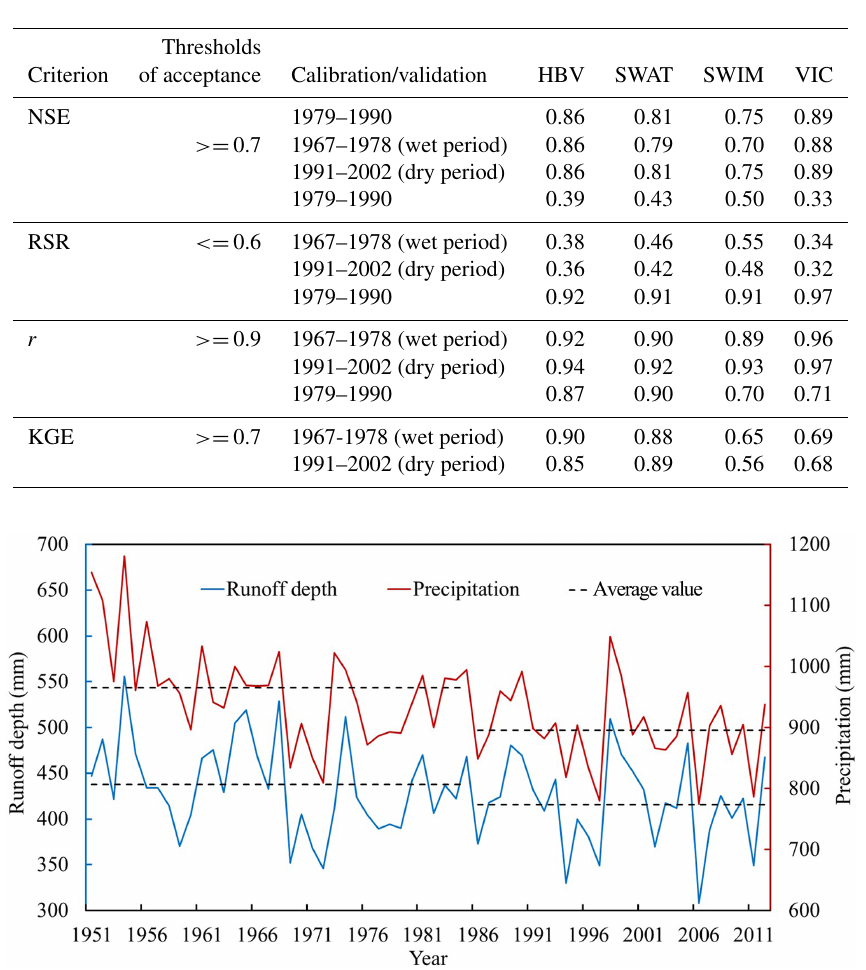
Table 6. Performance of four hydrological models in the upper Yangtze River at the calibration period and the wet and dry validation periods.